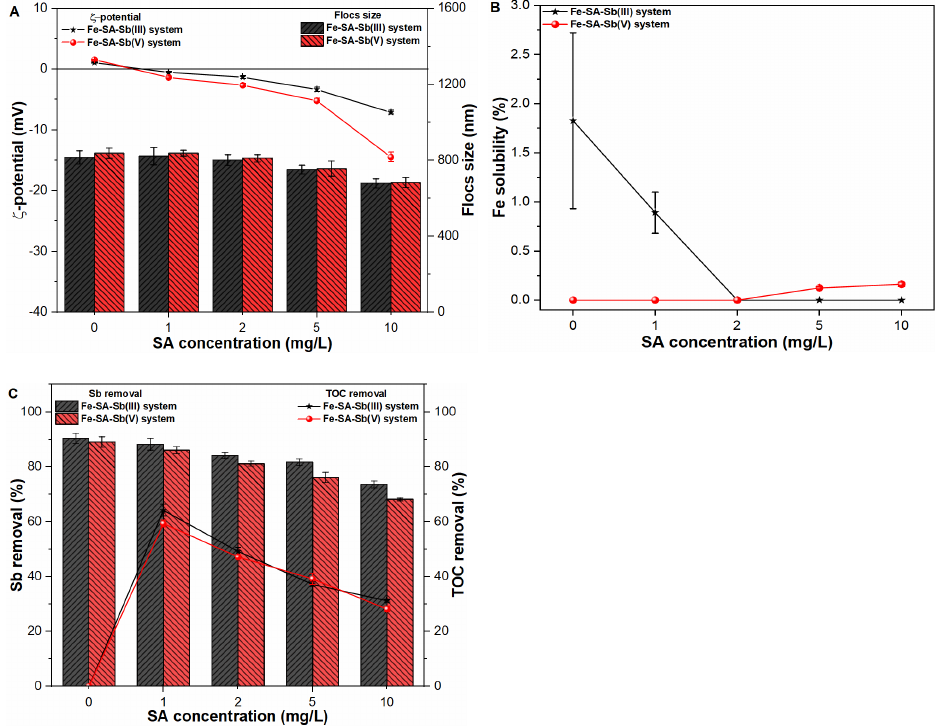
Figure 7. Influence of SA concentration on ( A ) zeta potential (mV) and size (nm) of freshly formed Fe flocs; ( B ) Fe solubility (%) and; ( C ) Sb removal (%) and TOC removal (%) in Sb(III, V) suspensions.